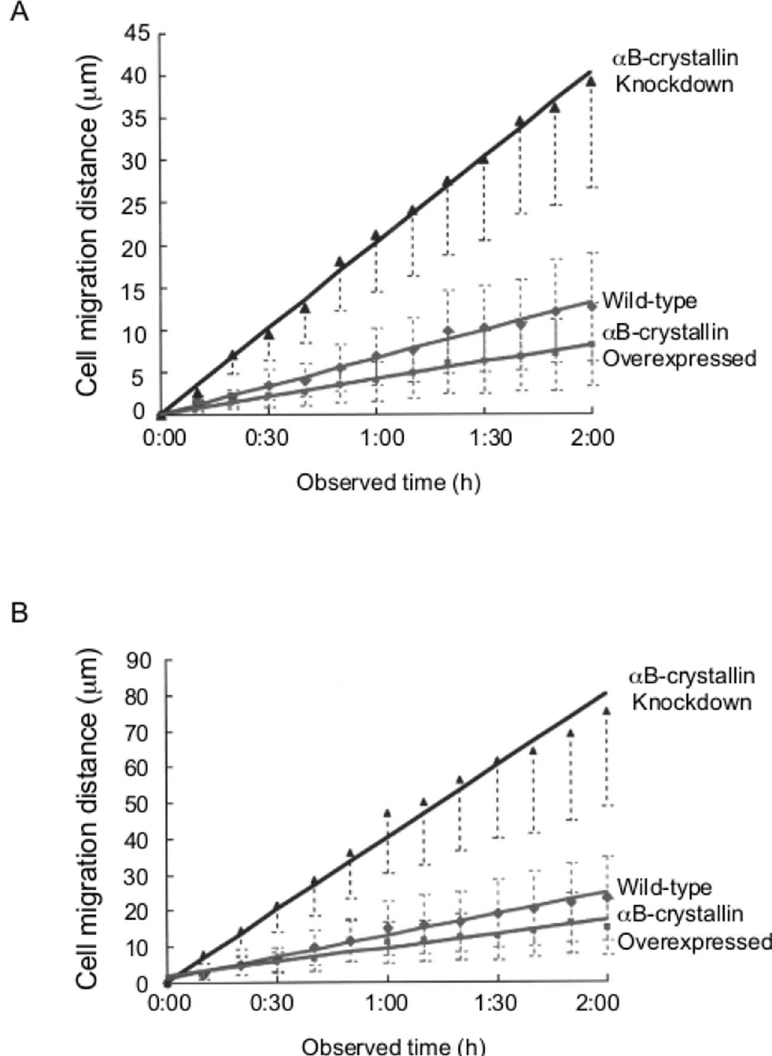
(A). Time-dependent migrationof wild-type, α B-crystallin-overexpressing and knockdownC6 gliomacells (n = 300). Cumulativemoving distanceswere obtainedfrom images captured every 10 min